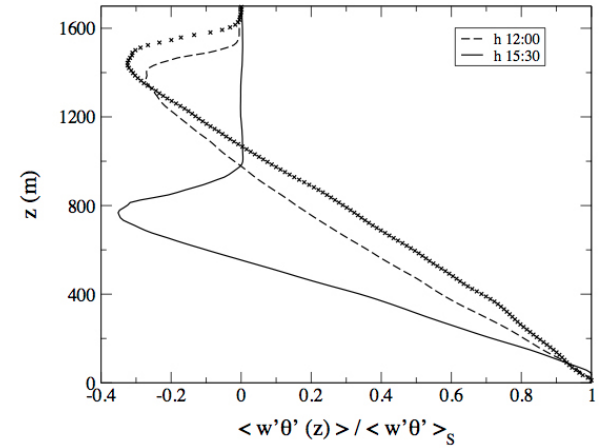
Fig. 12. The evolution of the sensible heat fluxes in the LES with subsidence and in the control case. The dashed line is from the LES run before turning on the subsidence; the continuous line is at 15:30UTC in the run with subsidence; the curve with crosses is from the control run, without subsidence.